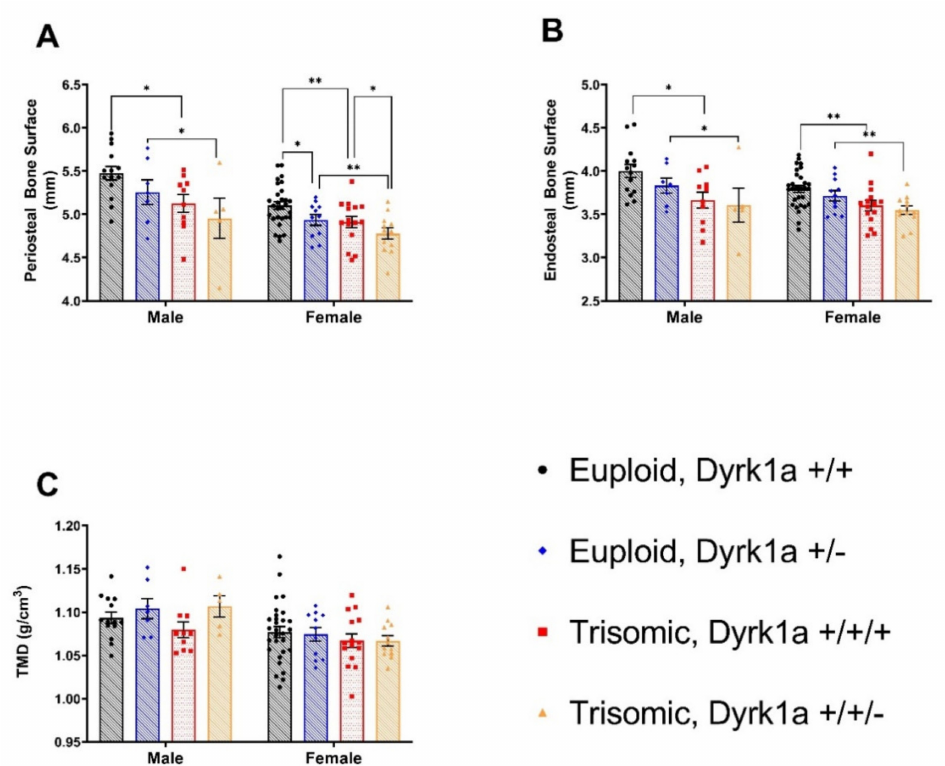
Figure 3. Cortical bone analysis revealed significant differences between male and female Euploid and Ts65Dn animals ( A – C ). ( A ) Periosteal Bone Surface (Ps.BS); main effect of ploidy in male and female mice; main effect of Dyrk1a genotype in female mice. ( B ) Endosteal Bone Surface (Es.BS); main effect of ploidy in male and female mice. ( C ) No significant differences between ploidy or Dyrk1a genotype. Mean ± SD; bars between groups of mice denote significance; p -value 0.1234 (ns); 0.0332 (*); 0.0021